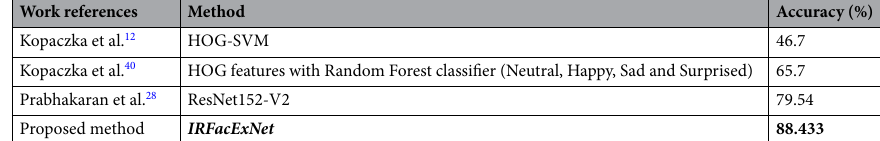
Table 4. Performance comparison of the proposed FER method with some past methods evaluated on IRDatabase. Bold value indicates result of the proposed methodology.